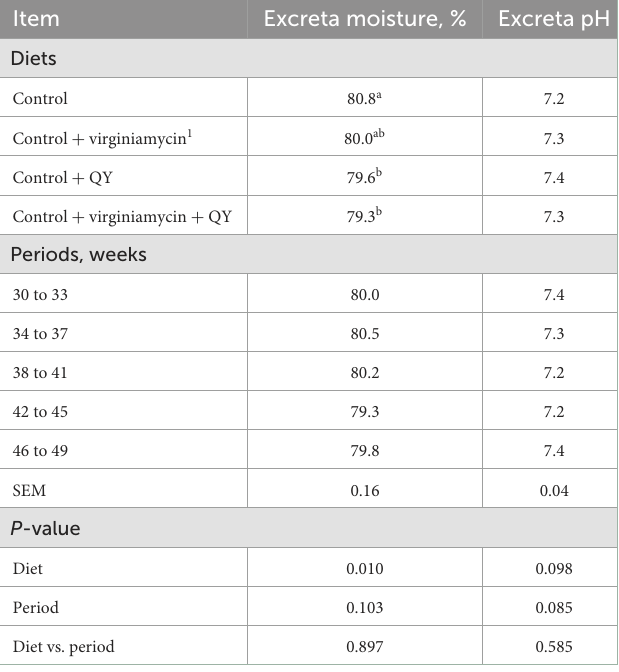
TABLE 4 Moisture and pH of excreta from laying breeder hens fed diets supplemented with an additive from Quillaja saponaria and Yucca schidigera (QY) from 30 to 49 weeks of